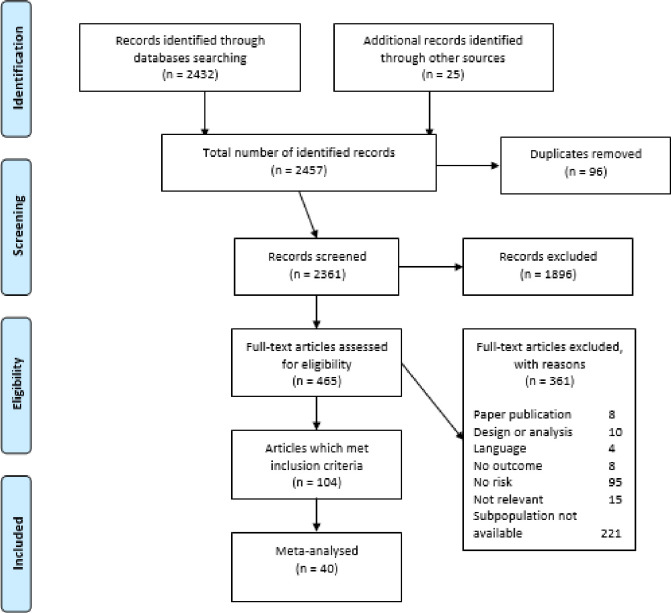
PRISMA flow diagram.